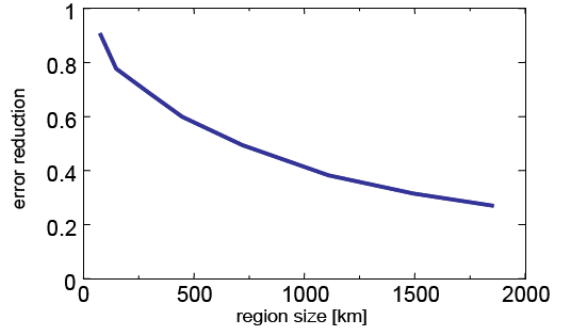
Figure 55. Measured forecast error as a function of spatial range of interconnection (© 2007 VTT, reproduced with permission from VTT Working Papers 82 [211]). The error reduction plotted on the y-axis is the ratio of the root-mean-square error (rmse) of prediction at a regional scale, and the single-site prediction